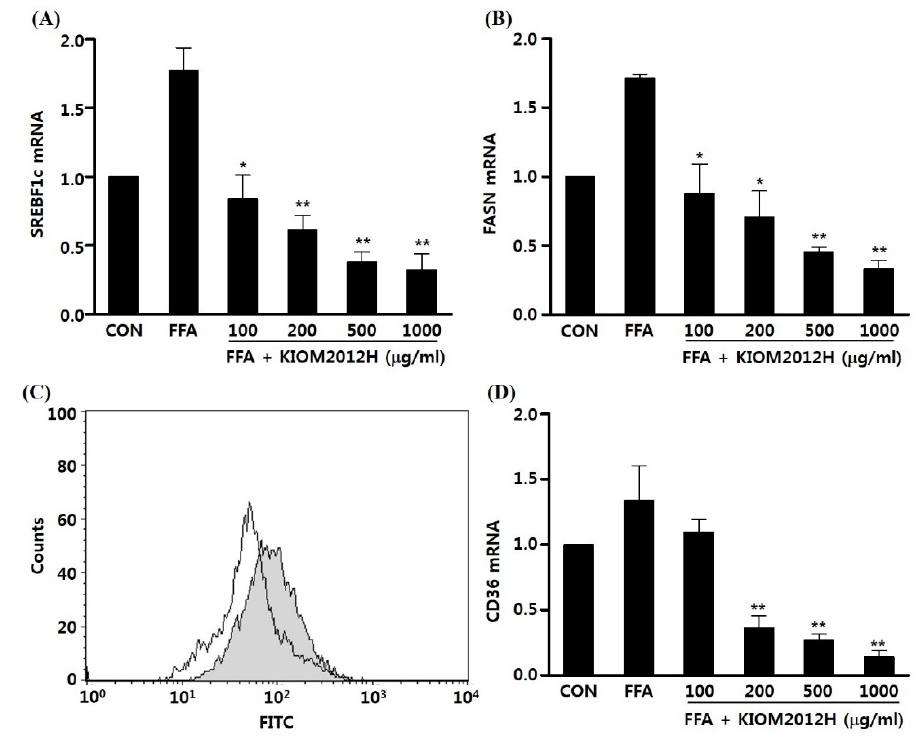
Figure 4. KIOM2012H attenuates lipogenic mRNA gene expression and fatty acid import. HepG2 cells were treated with 1 mM FFA in the absence or presence of various concentrations of KIOM2012H for 24 h. qRT-PCR analysis shows decreased mRNA levels of SREBF1c ( A ) and FASN ( B ); Cells were incubated with the BODIPY-labeled fatty acid C16 in the absence (gray) or presence (white) of KIOM2012H and fluorescence was measured by flow cytometry ( C ); Fatty acid translocase CD36 gene expression was also dose dependently down regulated by KIOM2012H ( D ). Data represent mean ± SE of three independent